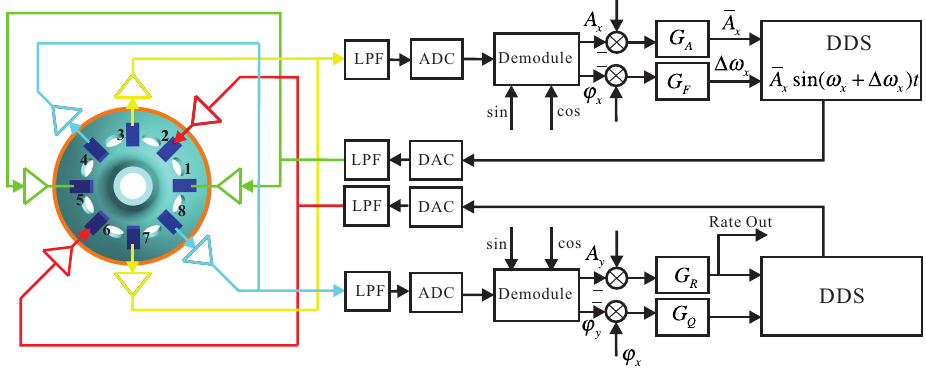
Figure 4. The circuit system signal flow.